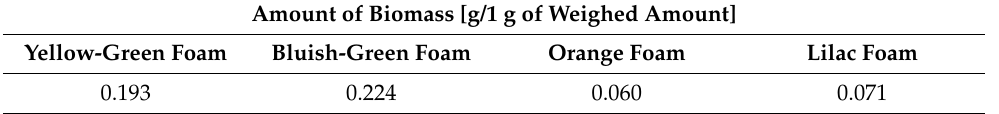
Table 1. Mean content of biomass immobilized on waste PUFs with open pores (group I) after 54 h of batch culture. Amount of Biomass [g/1 g of Weighed Amount] Yellow-Green Foam Bluish-Green Foam Orange Foam Lilac Foam 0.193 0.224